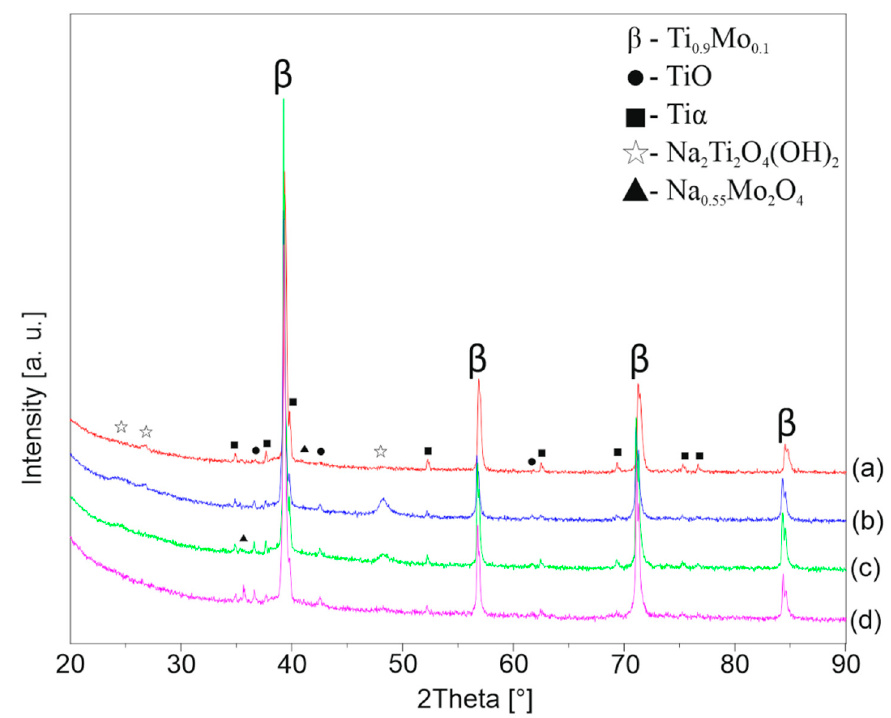
Figure 7. XRD patterns of Ti27Mo after alkaline treatment in ( a ) 5 M, ( b ) 7 M, ( c ) 10 M, ( d ) 12 M NaOH solutions.